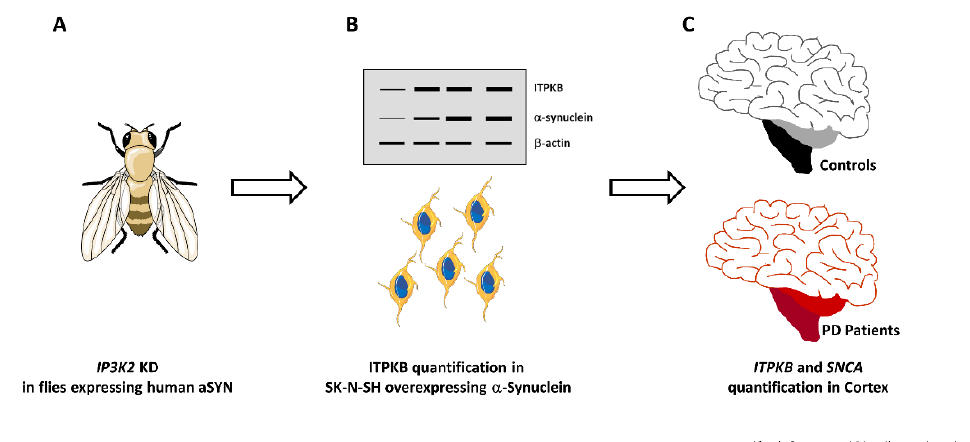
Figure 6. Experimental workflow. IP3K2 expression was reduced in flies overexpressing human α -synuclein. Geotaxis and lifespan PD-related phenotypes were measured ( A ). ITPKB was quantified in SK-N-SH cells overexpressing wild-type or mutated A53T or A30P α -synuclein by western blot ( B , top). ITPKB protein level was measured also in the cytoplasm and in the nucleus of cells, separately ( B , bottom). ITPKB and SNCA mRNA levels were quantified in cortex from PD patients and controls ( C ) .